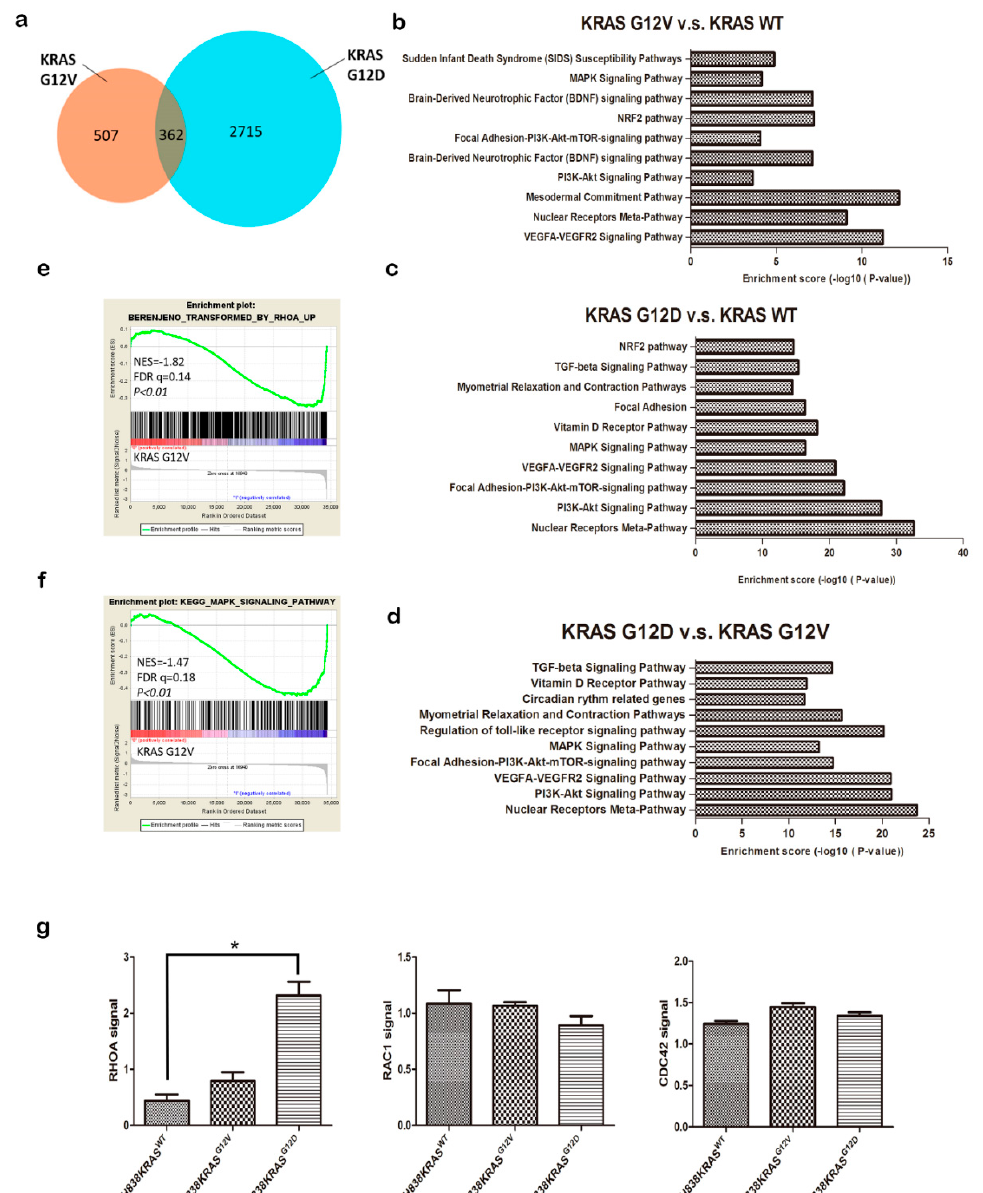
Figure 4. Microarray analysis of differentially regulated genes between H838 KRAS G12V and KRAS G12D cells. ( a ) Venn diagram representing the number of genes that was differentially expressed in H838 KRAS G12V and KRAS G12D cells with a fold change of 2.0 and a false discovery rate of 0.05. ( b ) Number and categories of genes up- and downregulated in H838 KRAS G12V cells. ( c ) Number and categories of genes up- and downregulated in H838 KRAS G12D cells. ( d ) Number and categories of genes up- and downregulated in H838 KRAS G12V vs. H838 KRAS G12D cells. The number of genes expressing a twofold or greater significant difference ( p ≤ 0.05) is plotted for the listed categories. ( e ) The correlation between RhoA pathway and KRAS G12V by Gene Set Enrichment Analysis (GSEA). ( f ) The correlation between MAPK pathway and KRAS G12V by GSEA. The normalized enrichment score (NES) and p value are shown. ( g ) The activation of Rho GTPase family proteins (RhoA, Cdc42, and Rac1) in H838 KRAS isogenic cell lines was evaluated by G-LISA assays. The values represent the means ± s.d. of five independent assays ( n = 5, * p < 0.05 and ** p <